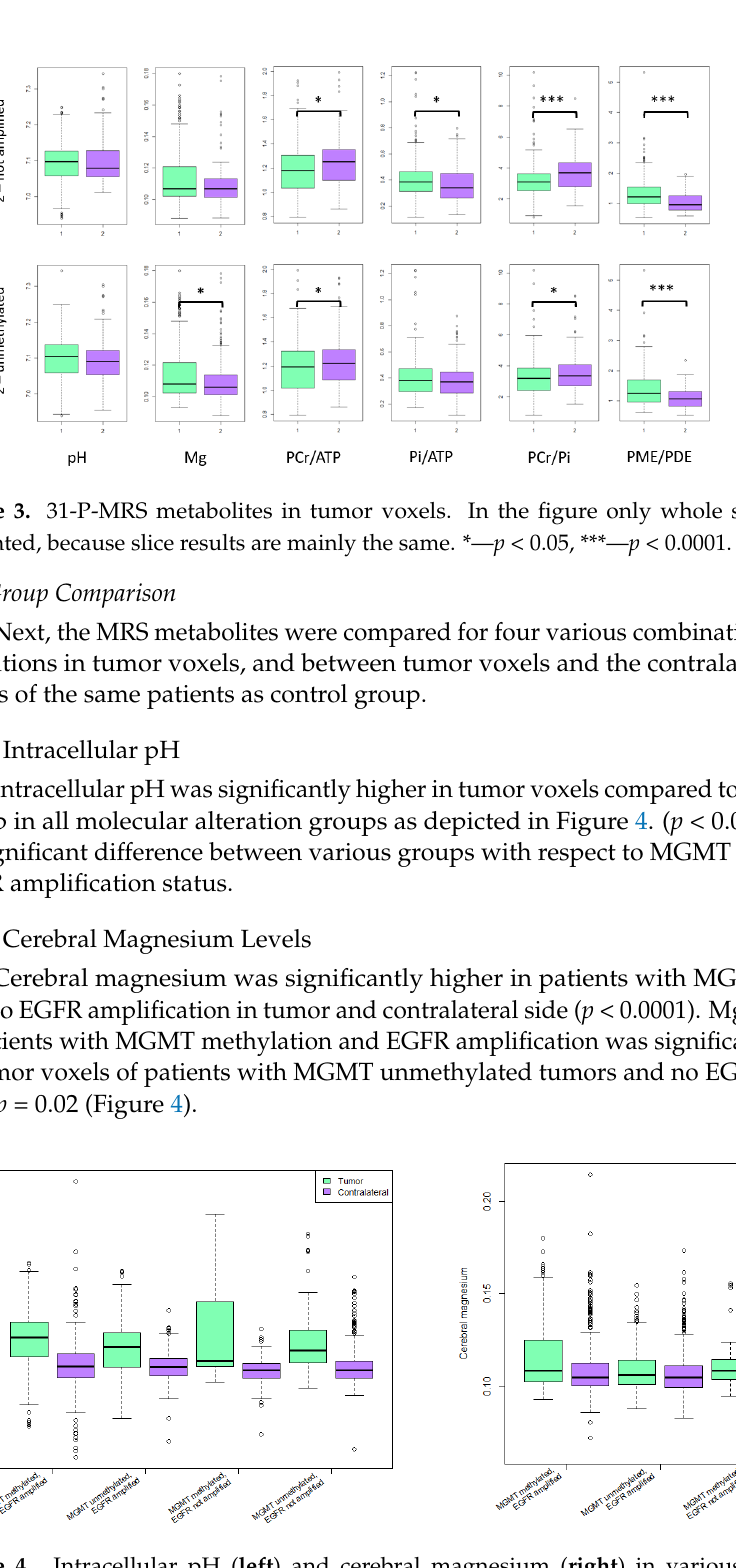
Figure 4. Intracellular pH ( left ) and cerebral magnesium ( right ) in various combinations of molecular